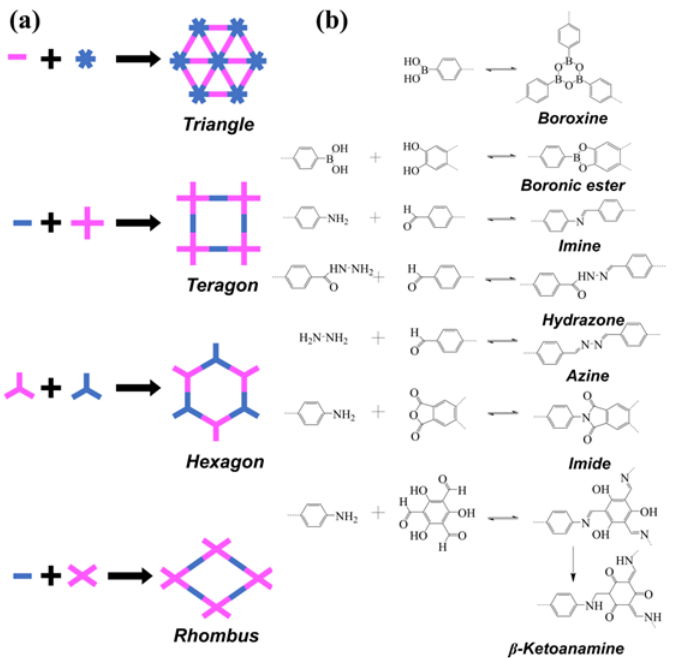
Figure 2. ( a ) The geometry of the building blocks of 2D COFs; ( b ) Different reactions for the for- mation of COFs. of